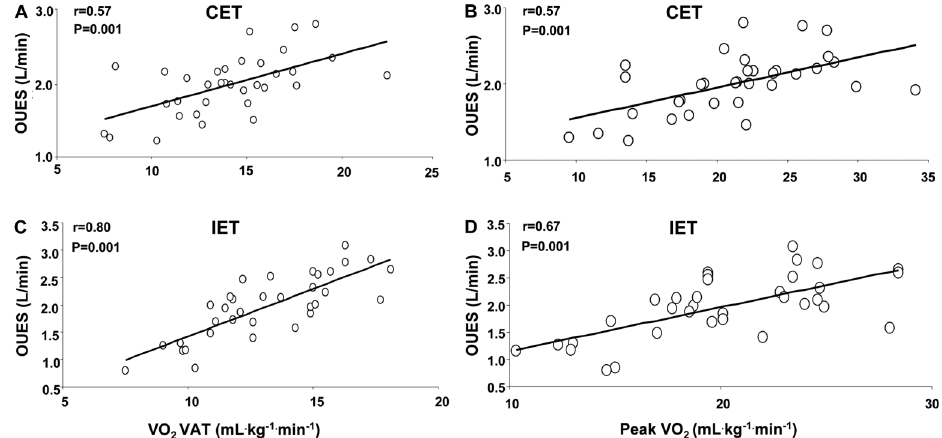
Figure 1. Relationship between oxygen uptake ef fi ciency slope (OUES) and aerobic fi tness in patients with coronary artery disease subjected to continuous exercise training (CET; A and B ) and interval exercise training (IET; C and D ). VO 2 VAT: oxygen consumption at ventilatory anaerobic threshold; peak VO 2 : peak oxygen